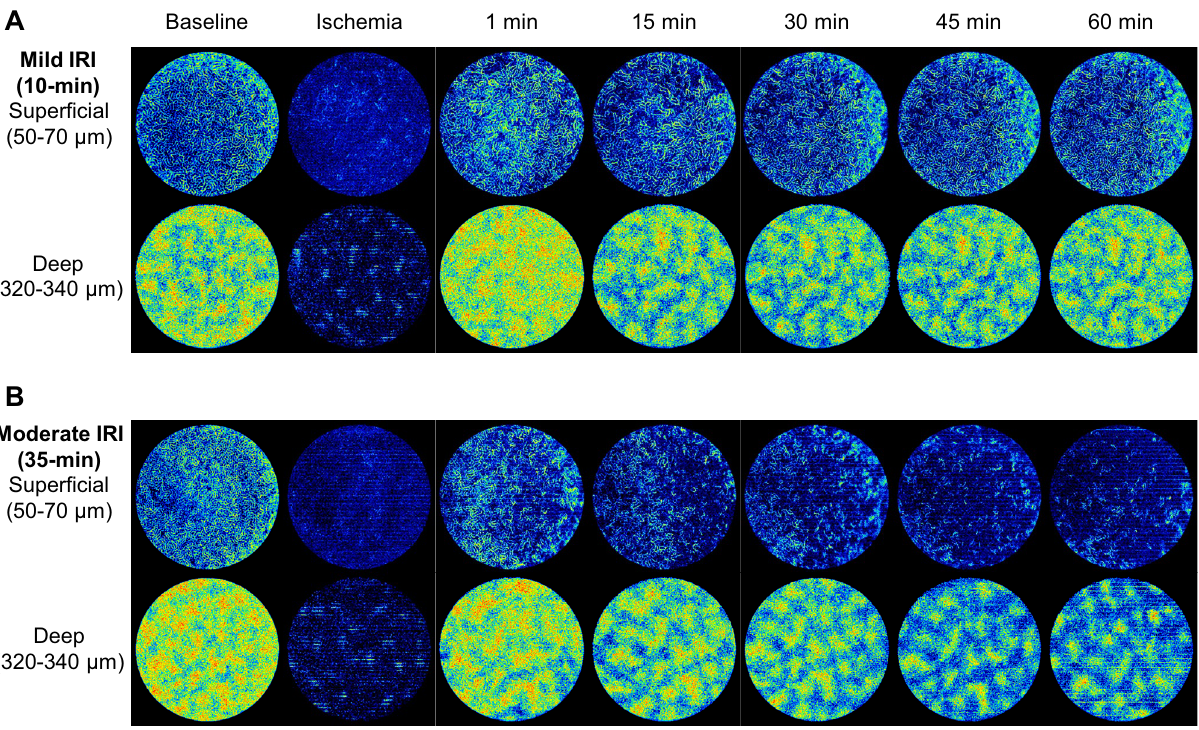
Figure 3. Results of the semi-quantitative OCTA blood flow measurement in the murine kidney IRI model. Representative time course of the OCTA signal in the superficial and the deep capillary layers of mild (10-min) and moderate (35-min) IRI